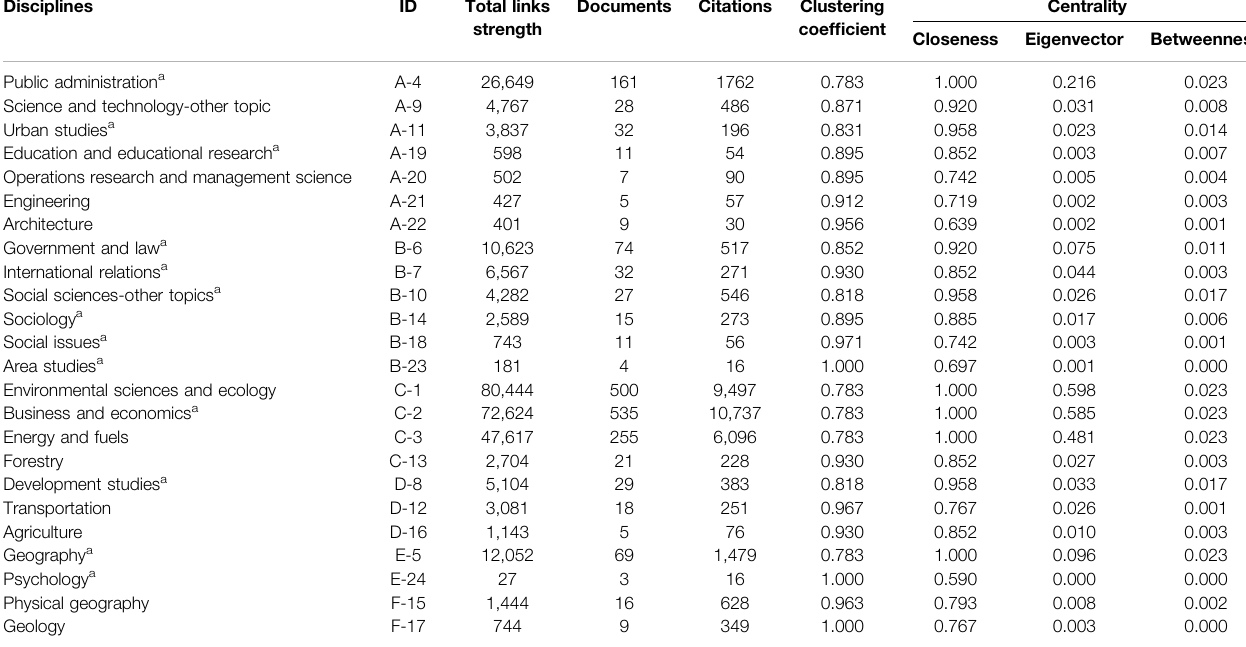
TABLE 8 | Main disciplines: key scientometric metrics. Disciplines ID Total links